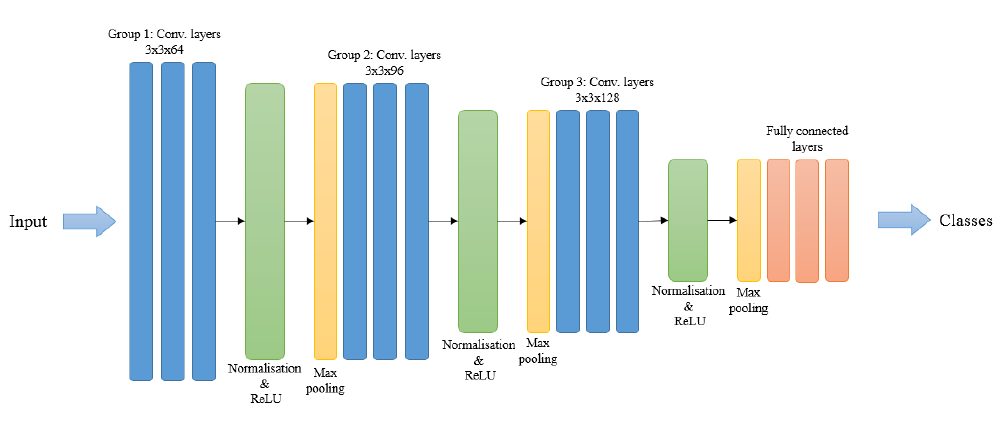
Figure 6. Architecture of the deep motion